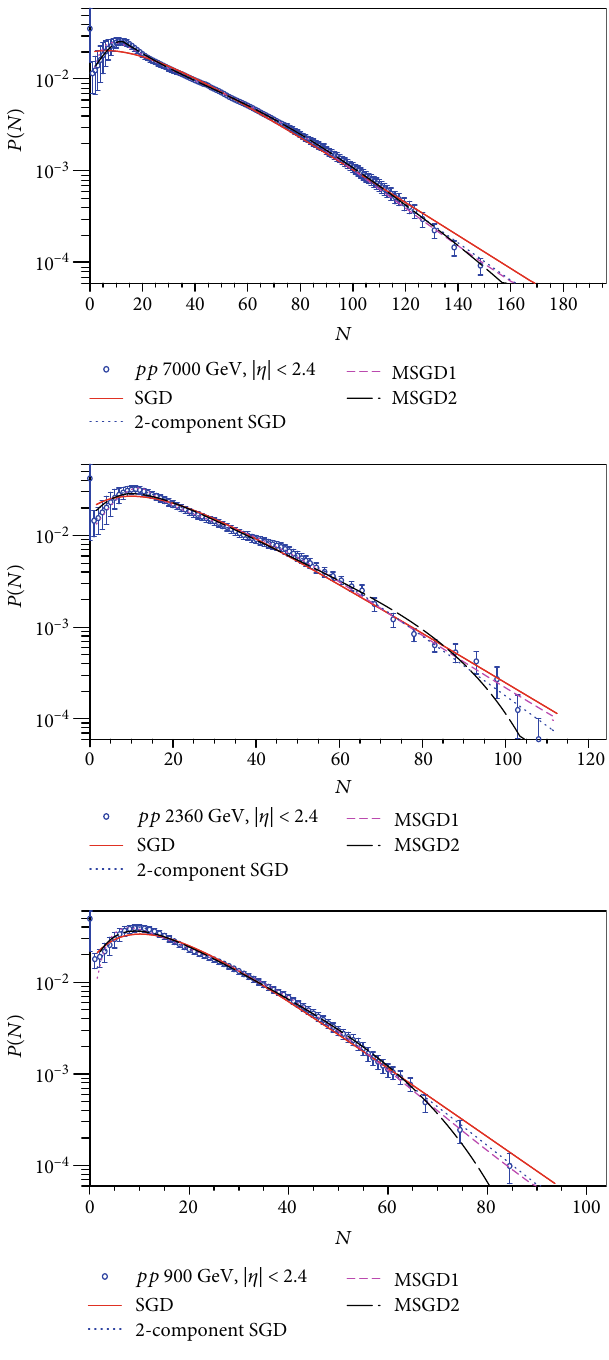
Figure 1: SGD, 2-component SGD, MSGD1, and MSGD2 distributions for data on pp collisions at di ff erent the CMS experiment for j η j < 2 : 4